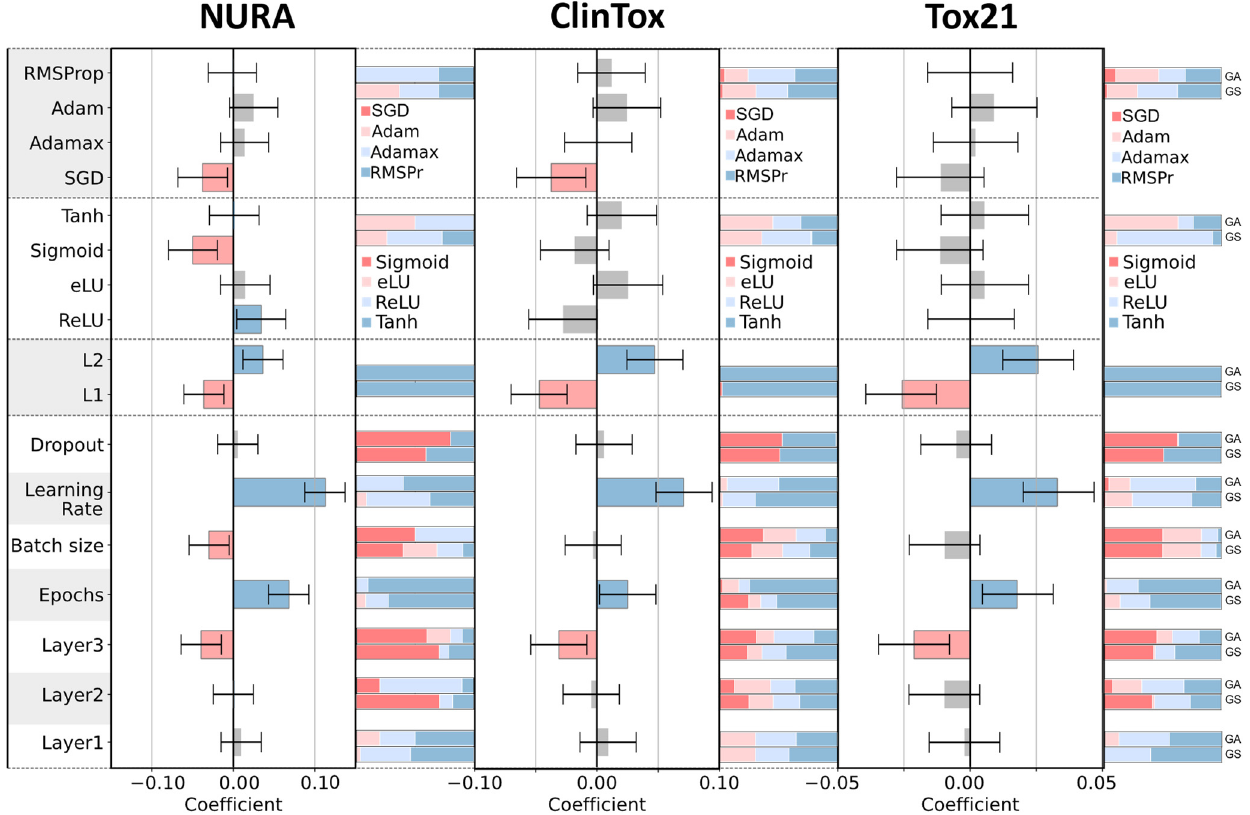
Figure 4. Coefficients of the D-optimal models and relative frequency bars of the hyperparameters among the genetic algorithms (GA) final population (upper bar) and the best 1000 architectures obtained with the grid search (GS) strategy (lower bar). For quantitative hyperparameters, the bars are colored according to Figure 5.